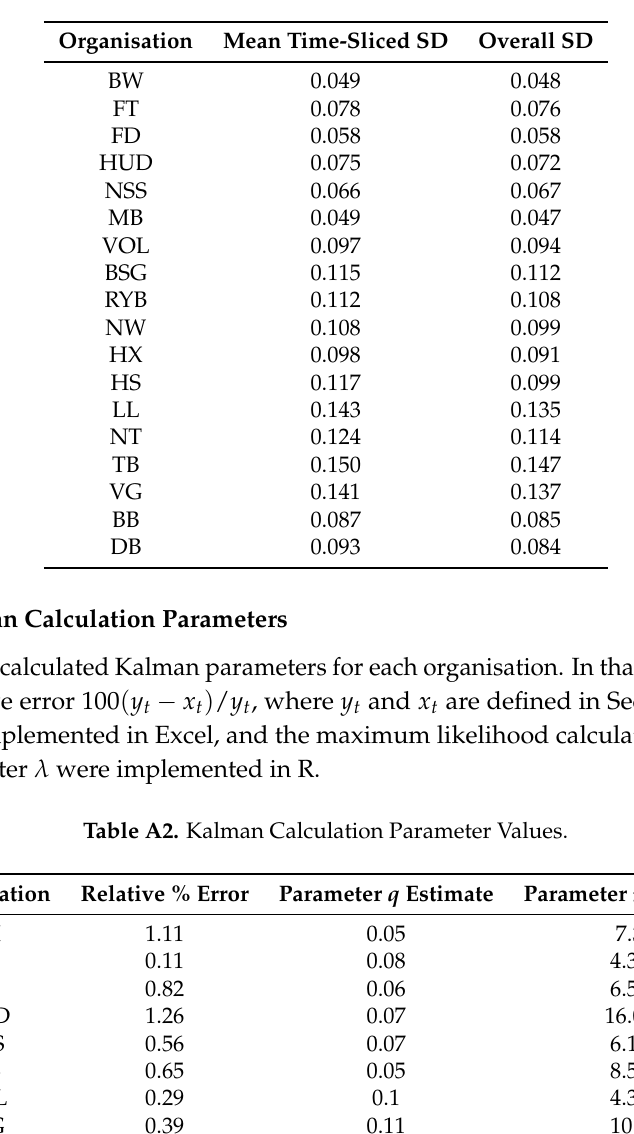
Table A1. Comparison of Mean of Time-sliced Standard Deviations and overall Standard Deviation of Reputation Signals.